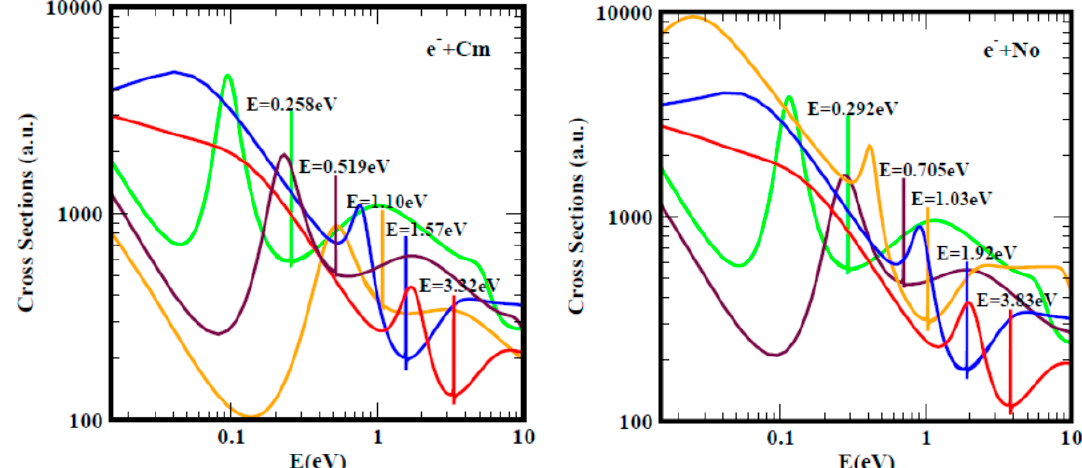
Figure 3. The total cross sections (a.u.) for electron elastic scattering from atomic Cm (left panel) and No (right panel) are contrasted. For both Cm and No, the red, blue and orange curves represent TCSs for the ground and metastable states, respectively. The brown and green curves denote TCSs for the excited states. The dramatically sharp resonances in both figures correspond to the Cm − and No − negative ions formation during the collisions.